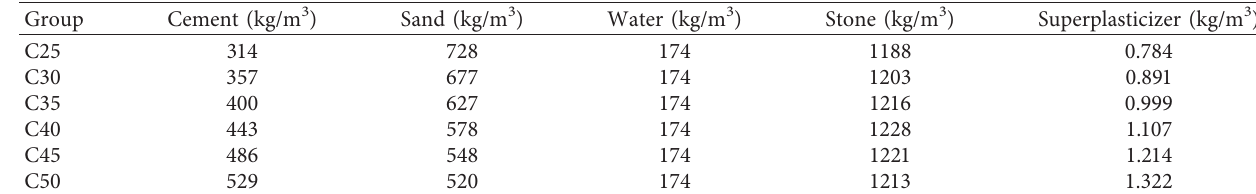
Table 2: Mixing proportions of the different grades of concrete.